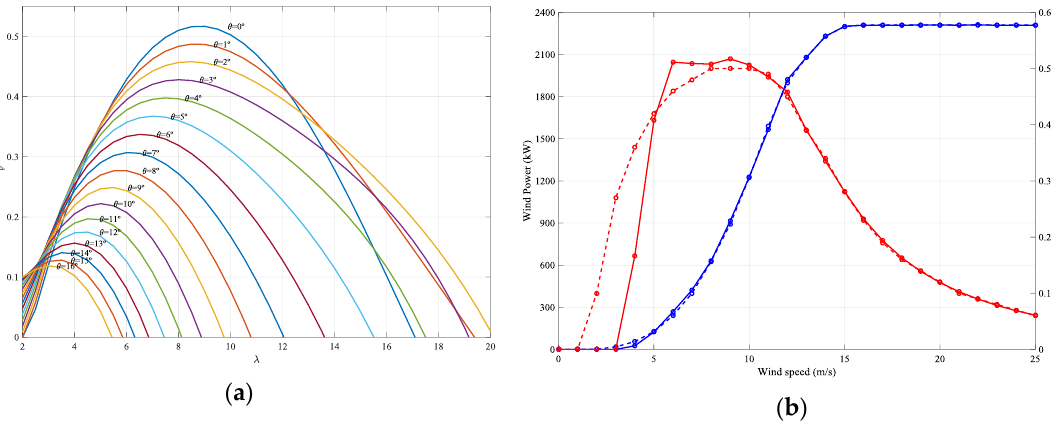
Figure 3. ( a ) Wind power C p ( λ , θ ) curves; ( b ) Comparison between C p (red) and power (blue) responses resulting from the model (continuous lines) and response provided by the manufacturer (dashed line) [58].